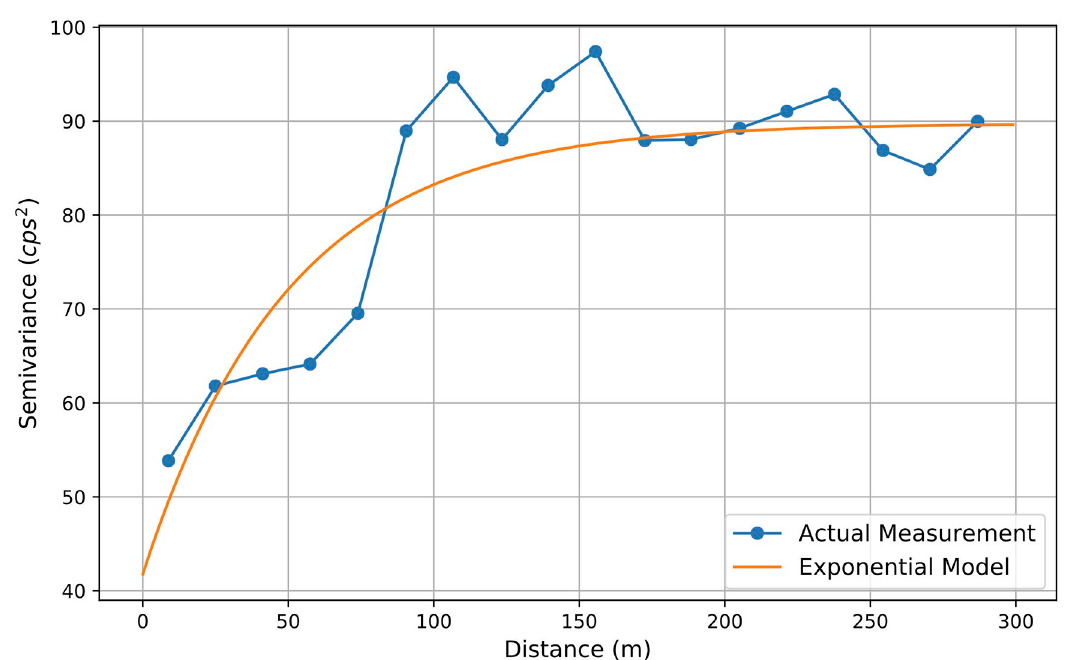
Fig 3. Semi-variogram plot of background radiation measurements.